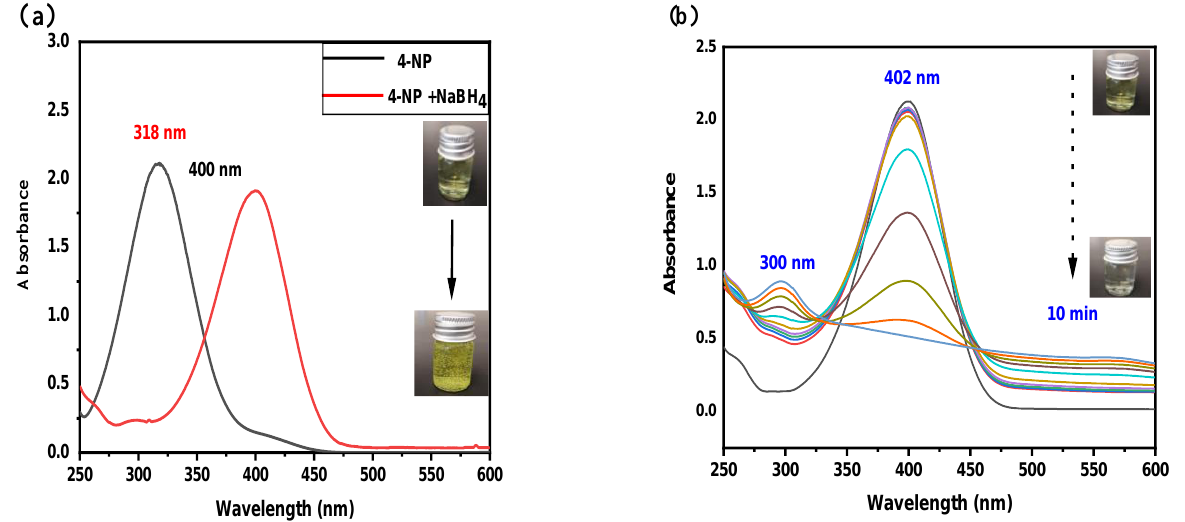
Figure 7. ( a ) Absorption spectra of 4-NP before and after the addition of aqueous NaBH 4 solution, ( b ) reduction of 4-NP with NaBH 4 in the presence of a CuO nanoplate catalyst.